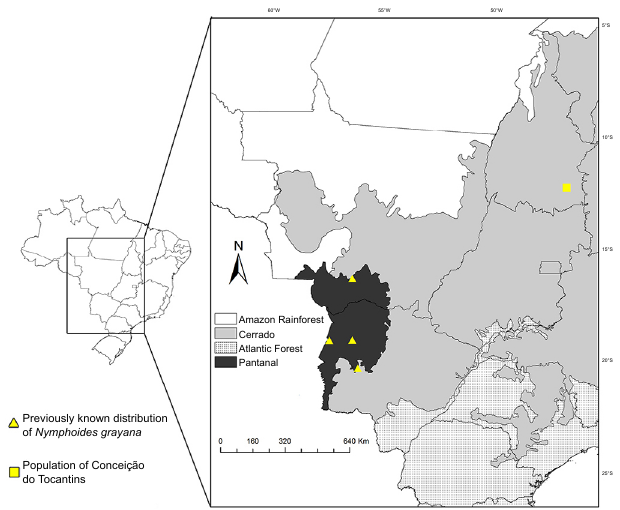
Nymphoides grayana